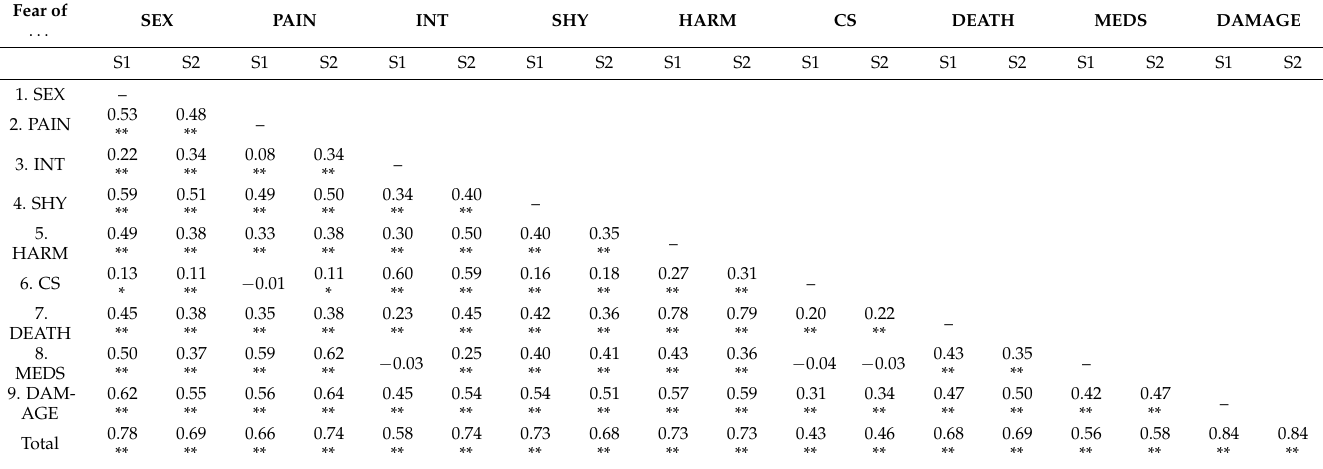
Table 6. CFQ total and subscale means (M) and standard deviations (SD). Subscale